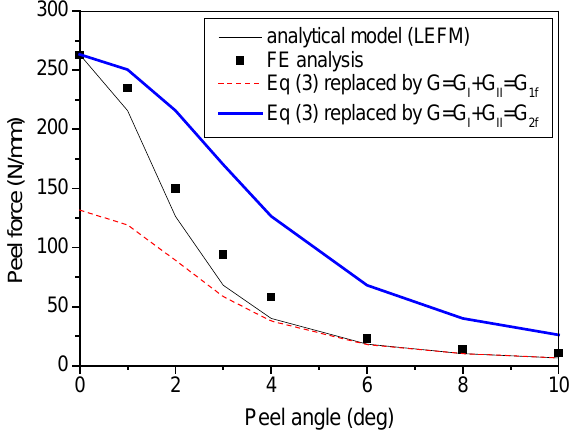
Figure 10. Steady peeling force vs. peel angle.